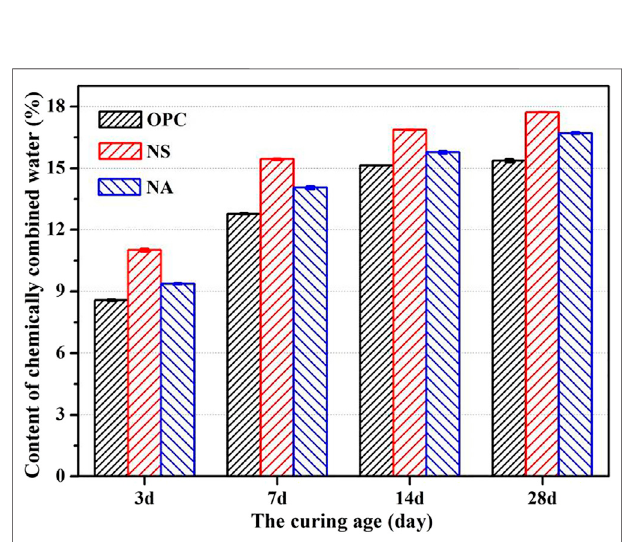
FIGURE 7 | The non-evaporable water of nano-modi fi ed concrete.